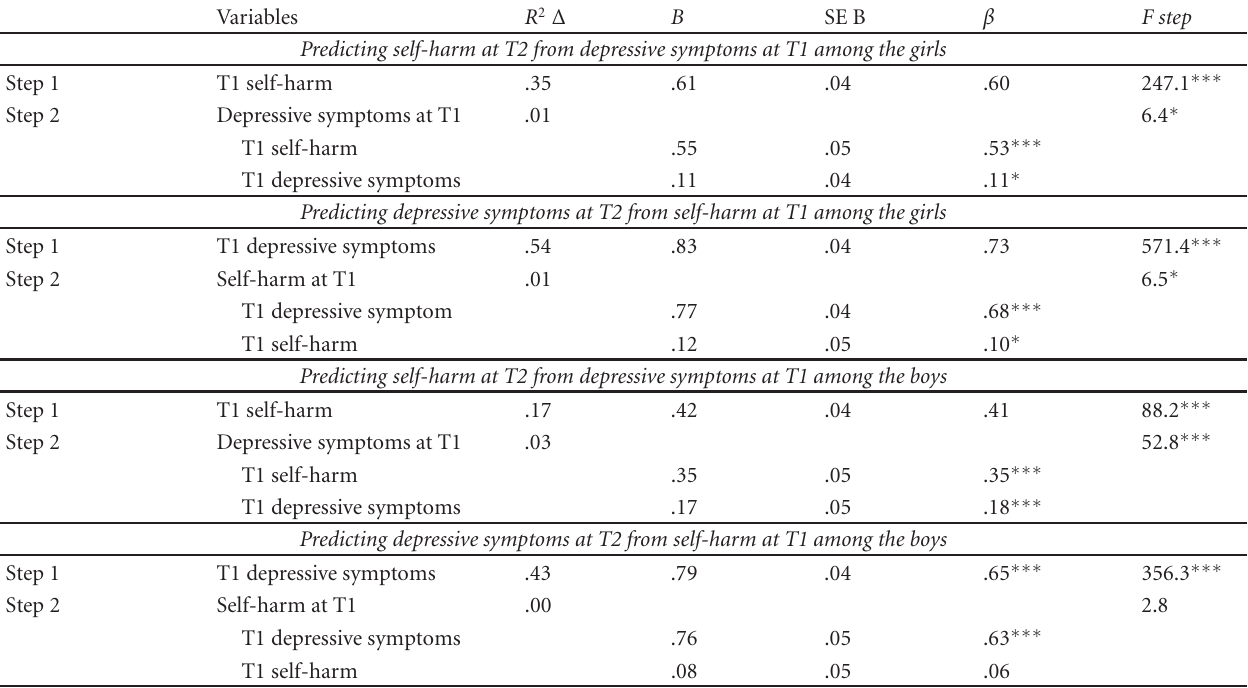
Table 2: Prospective hierarchical regressions, predicting T2 self-harm from T1 depressive symptoms and T2 depressive symptoms from T1 self-harm.